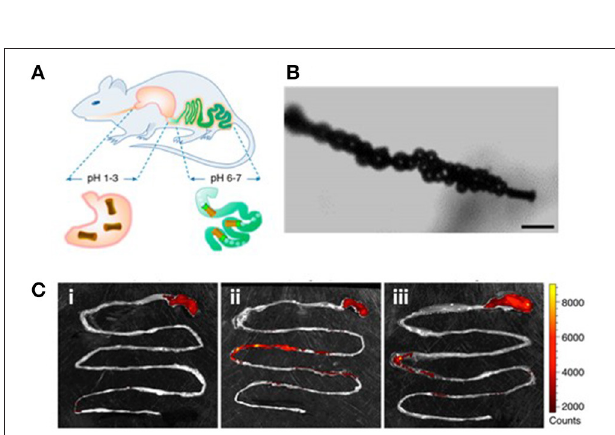
FIGURE 4 | Use of microrobots for enhanced retention of payloads in the gastrointestinal tract. (A) Schematic illustration of in vivo operation of microrobots in mouse model. (B) Micrograph illustrating the bubble generation at the end of the microorobot responsible for locomotion. Scale bar: 20 µ m. (C) Fluorescent images illustrating the gastrointestinal track retention of the dye Rhodamine 6G delivered by the chemically propelled microrobot (i: control, ii: after 6h, and iii: after 12h of administration. Reprinted with permission from Li et al. (2016). Copyright 2016 American Chemical